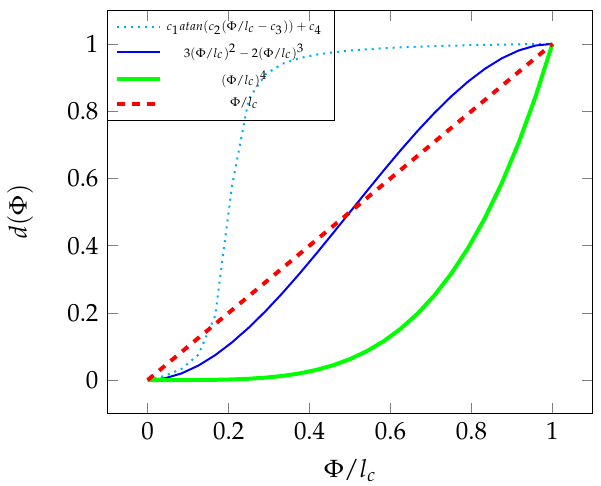
Figure 3. Possible damage profile choices with respect to the level set function Φ